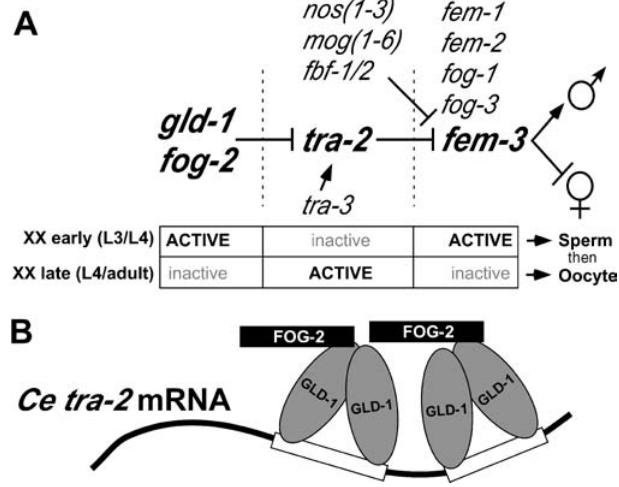
Figure 1. The C. elegans XX Hermaphrodite Germline Sex Determination Pathway (A) Genetic pathway for gene activity, where arrows represent positive regulation and bars represent negative regulation. The key genes tra-2 and fem-3 and the upstream regulators of tra-2 that are the focus of this work, fog-2 and gld-1, are in large bold font. The upstream genes fog-2 and gld-1, which are key regulators of tra-2 and addressed in this work, are also in large bold font. The gene activities at each level in the hierarchy are indicated below as ‘‘ ACTIVE ’’ in bold or ‘‘ inactive ’’ in grey. In L3 and L4 hermaphrodites the activities of fog-2 and gld-1 are high, leading to repression of tra-2 activity (also see [B]) and the de-repression of fem-3, resulting in the onset of spermato- genesis. In L4 and adult hermaphrodites the activity of fog-2 and gld-1 are low, leading to high tra-2 activity and the repression of fem-3, resulting in oogenesis. The shift in tra-2 / fem-3 balance allows for the switch from spermatogenesis to oogenesis in an otherwise female somatic gonad in the hermaphrodite. (B) C. elegans FOG-2/GLD-1/ tra-2 mRNA ternary complex. Current data indicates that FOG-2 and GLD-1 are required for the transla- tional repression of the tra-2 mRNA [25]. GLD-1 binds as a dimer to the tra-2 mRNA 3 9 UTR at two 28 nucleotide direct repeat elements (TGE/DRE, blocks) and FOG-2 makes contact with GLD-1 [32,34]. All three components are required for the proper specification of hermaphrodite